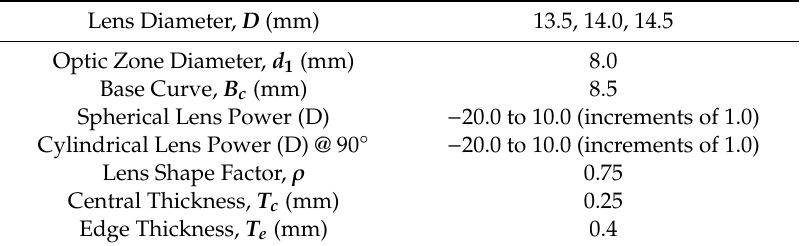
Table 1. Table 1. Geometrical properties used to inform the contact lens design